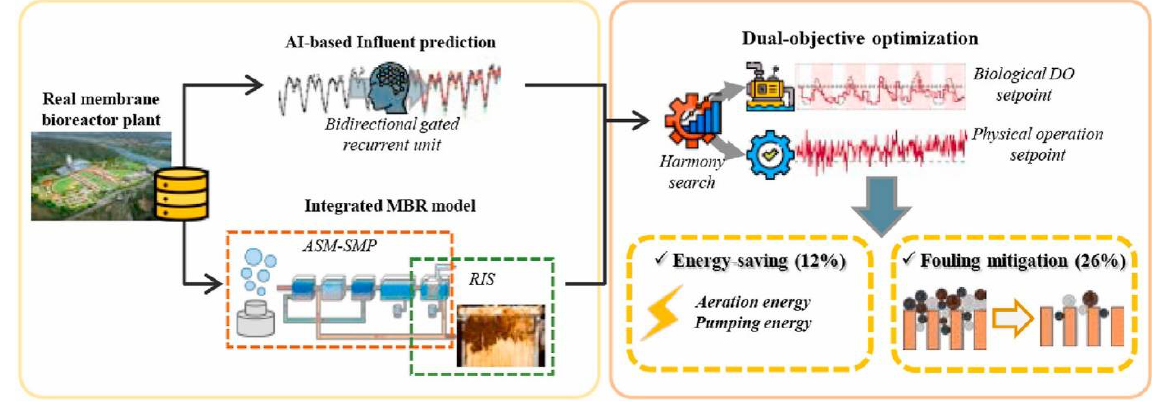
Figure 20. Benefits of dual-objective optimization system accurate forecasts of changing fluctuations in hourly influent [118].